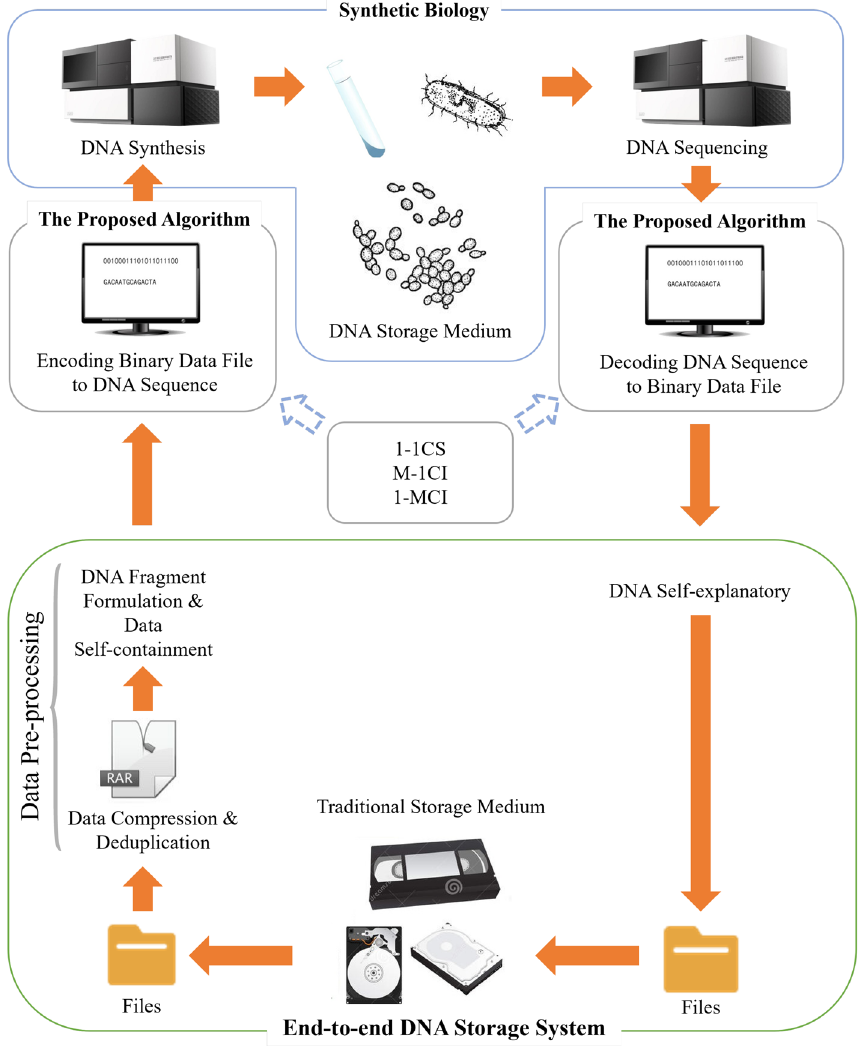
Figure 7. Overall DNA storage system architecture: The data files stored on traditional storage medium are pre-processed and handled by the proposed algorithm before being synthesised. The synthesised DNA can be restored by being sequenced to produce the original binary